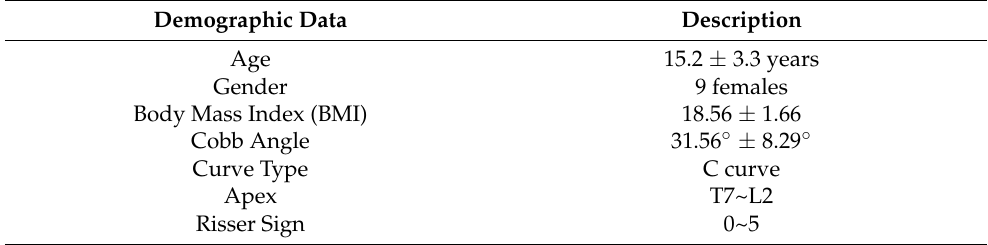
Table 1. Demographic data ( n = 9). Demographic Data